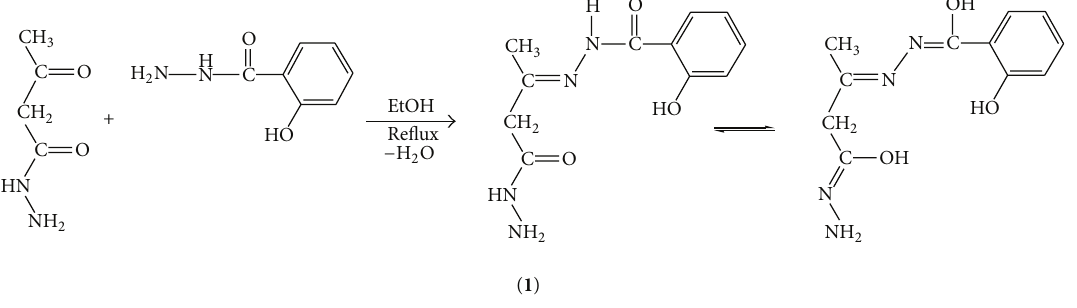
Scheme 1: Synthesis of the Schiff base.